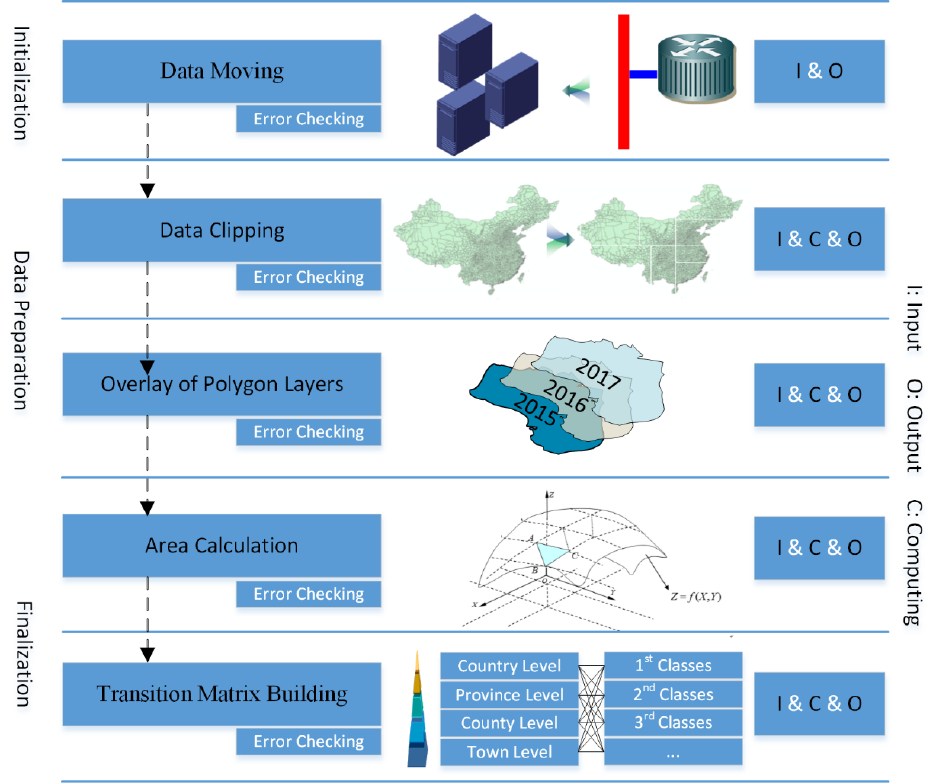
Figure 1. Workflow of the LUCC analysis.